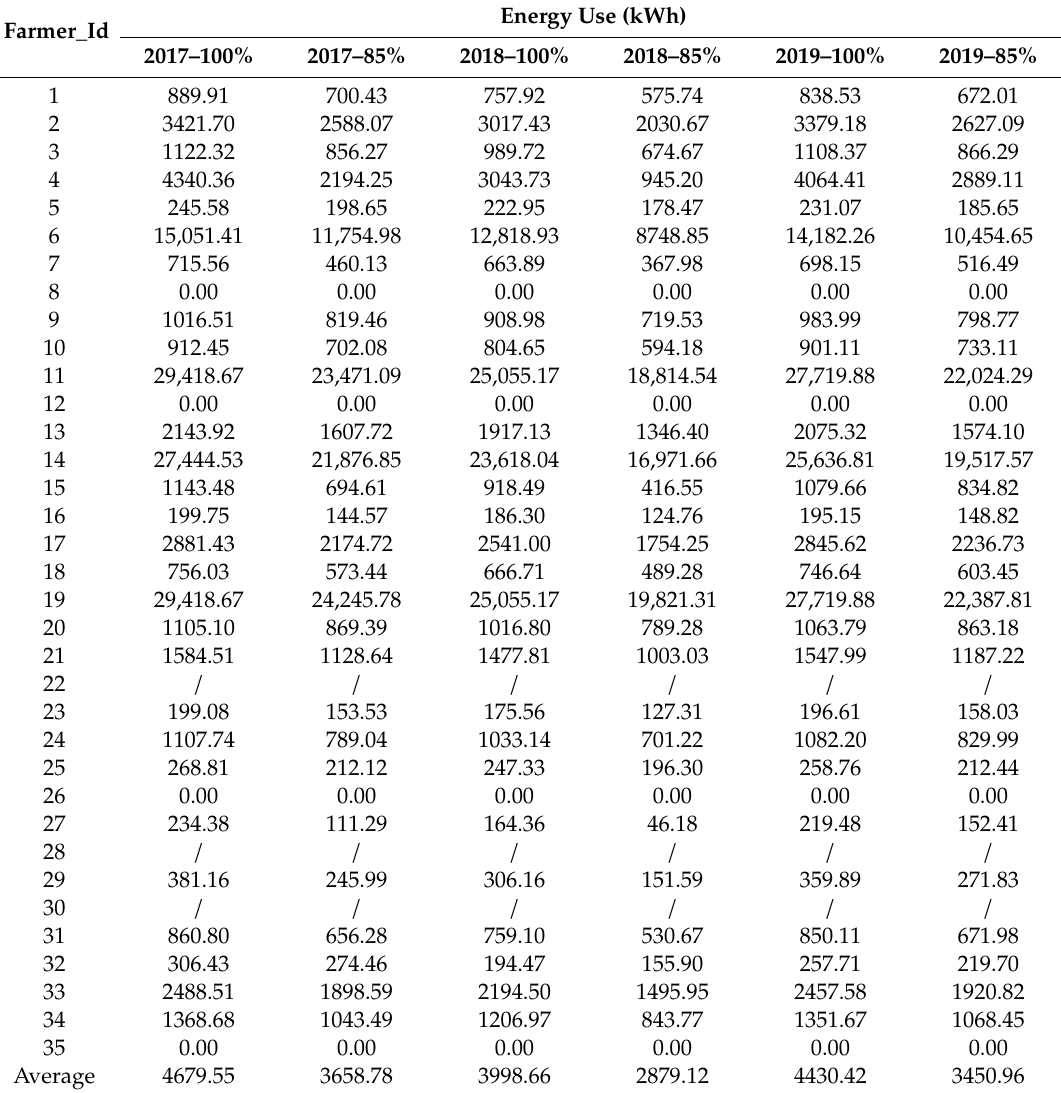
Table A9. Yearly energy use (kWh) due to irrigation at farm level by replenishing soil water content to (i) FC and (ii) to 85% capacity